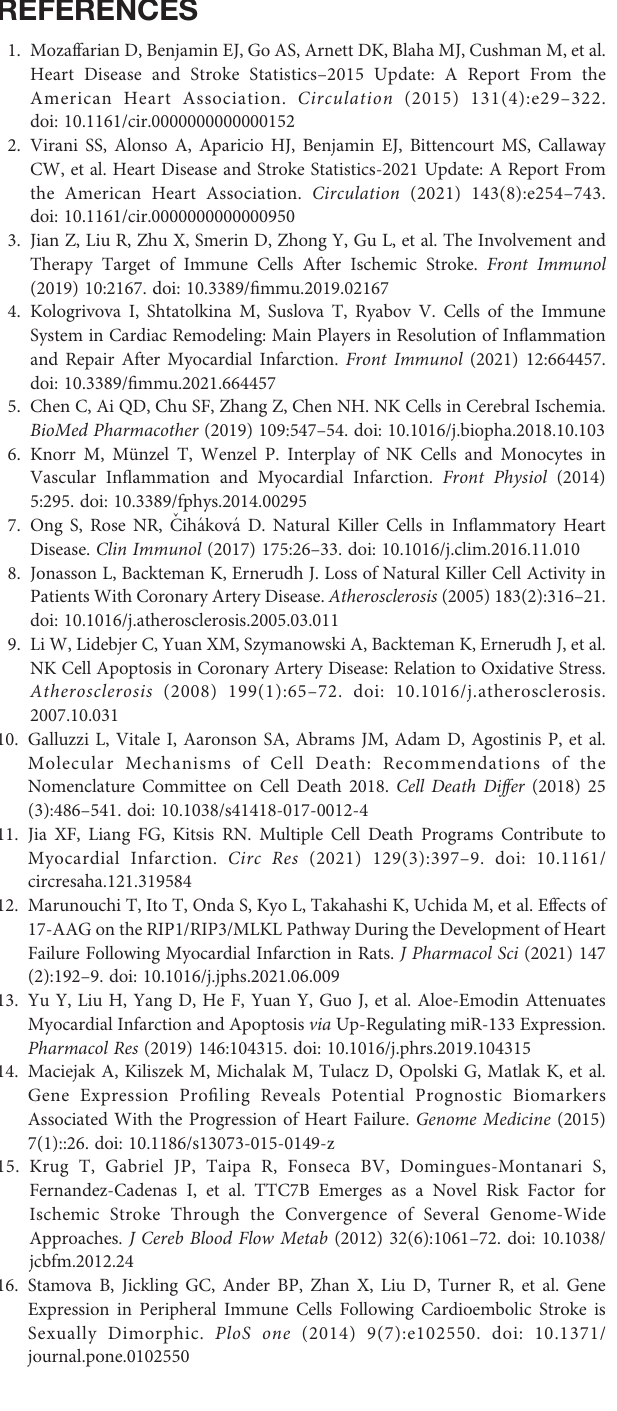
Supplementary Figure 2 – 3 | Pearson correlation coef fi cient between immune cells andcelldeathin(Left) AMIand(Right) IS. The Pearson correlation coef fi cientwas